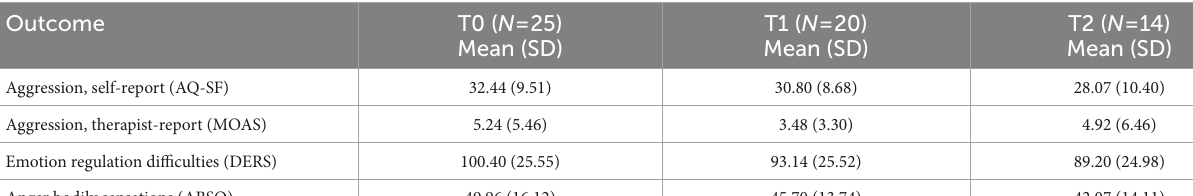
TABLE 3 Overview of clinical outcomes at pre-, post- and follow-up measurement.